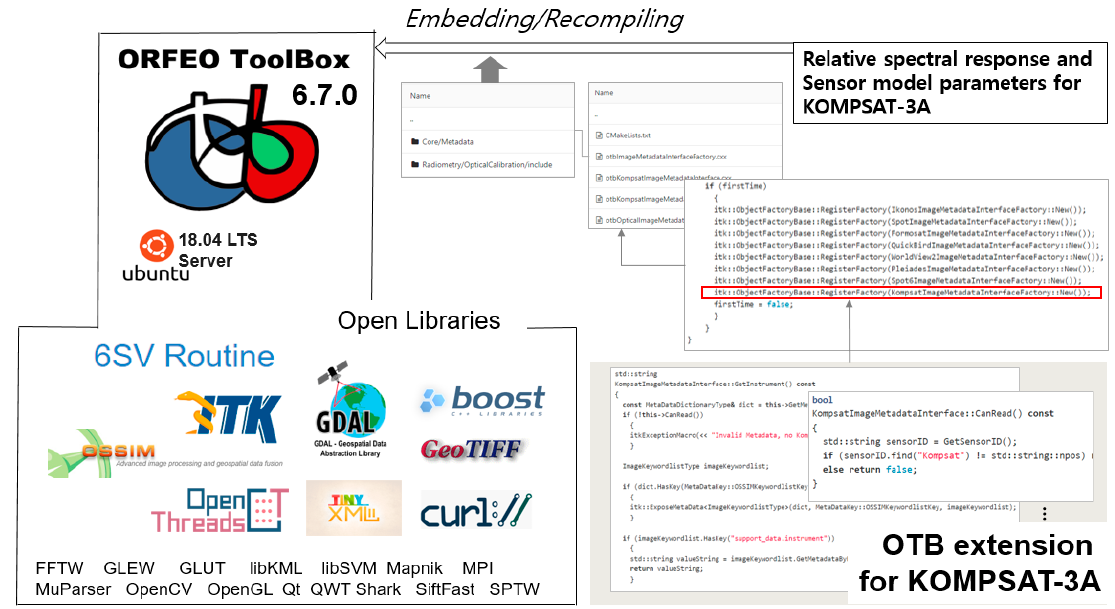
Figure 3. The recompiling process for the Orfeo ToolBox (OTB), its external libraries, and OTB extension for KOMPSAT-3A on Ubuntu. Modified from [20].